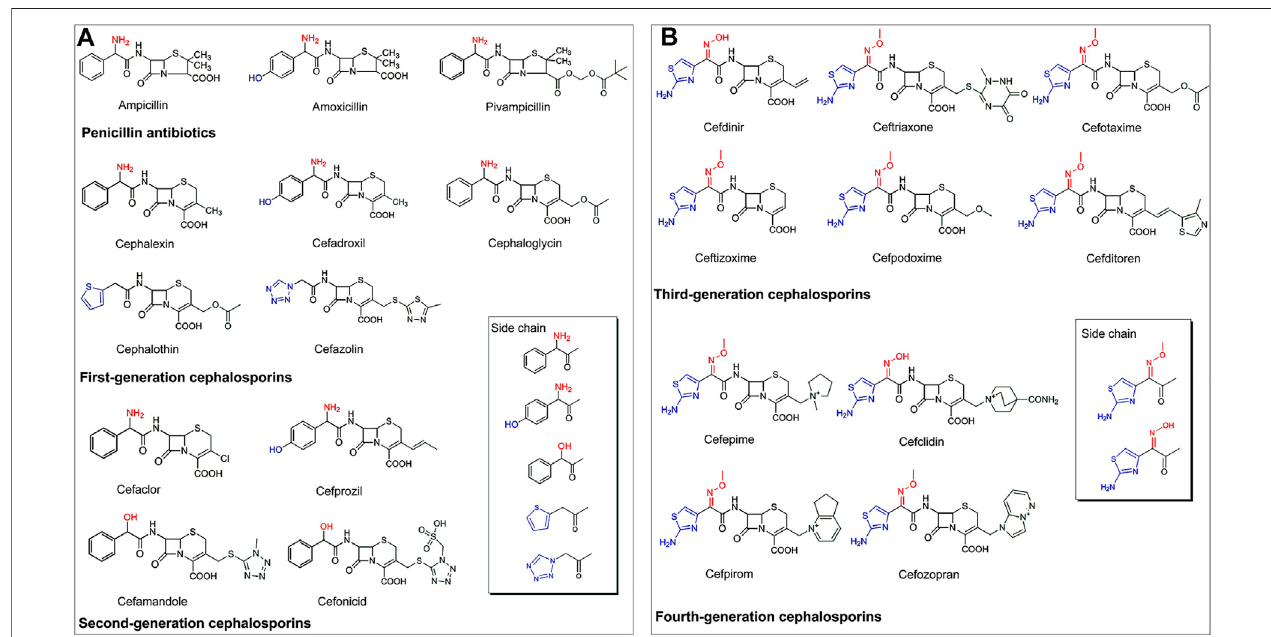
FIGURE 2 | (A) The structure characteristics of PGA-catalyzed semisynthetic penicillins, fi rst- and second-generation cephalosporins. (B) The structure characteristics of third- and fourth-generation cephalosporins.